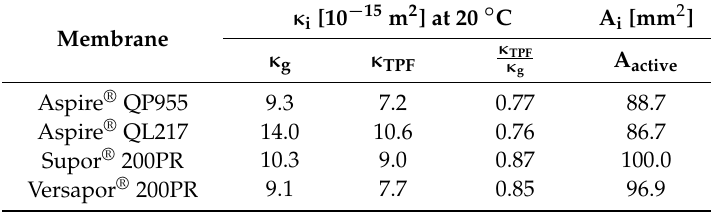
Table 5. Comparison of the gas permeability under single and two-phase flow